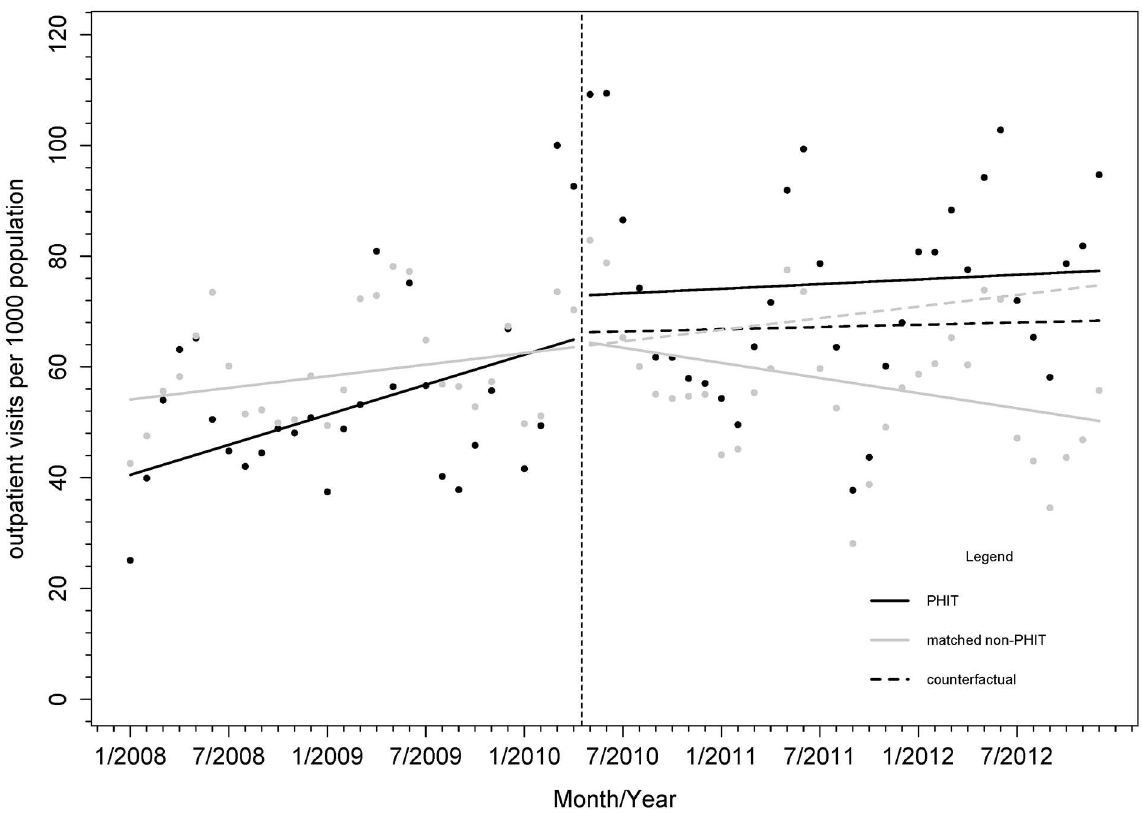
Fig 4. Monthly rates of outpatient visits (count per 1,000 catchment population) in PHIT health facilities (n = 13) or comparison propensity score matched facilities (n = 86). Notes: Vertical line indicatesstart of PHIT HSS intervention in May